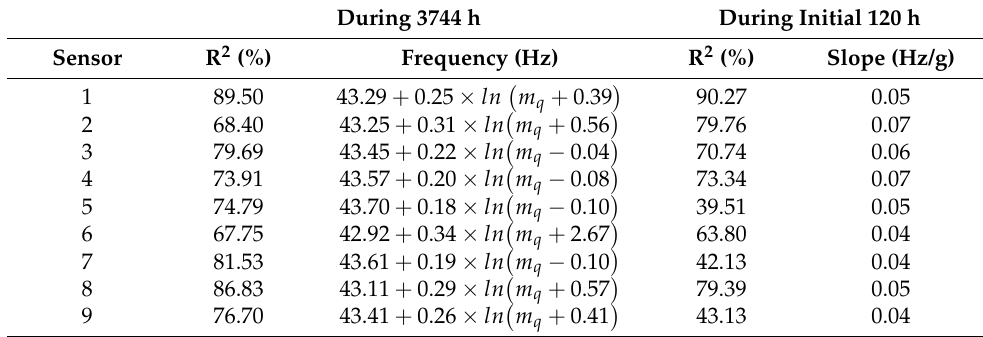
Table 4. Results observed in the correlation between frequency and calculated lost mass.